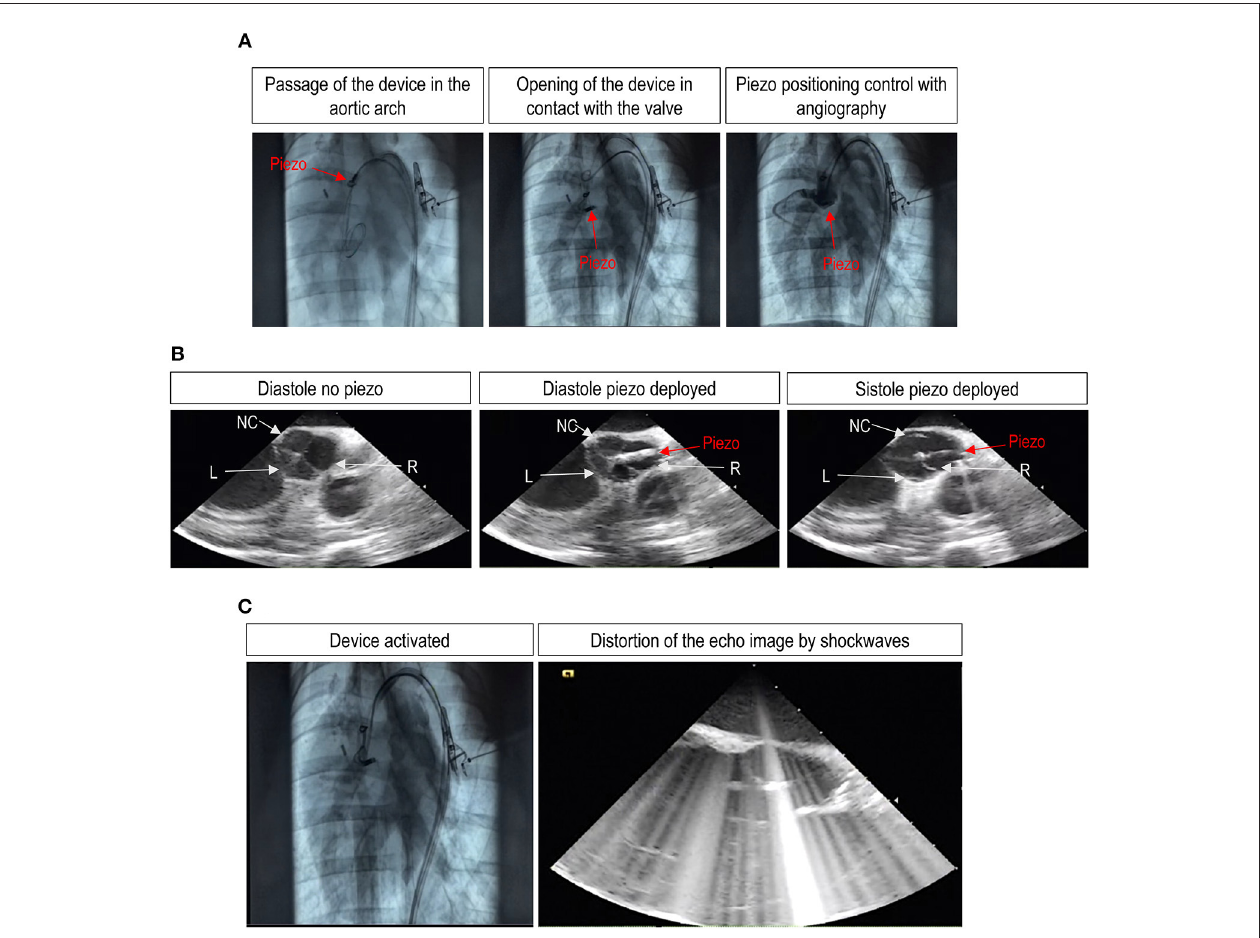
FIGURE 4 | Angiographic and echocardiographic assessment of successful TDD deployment and leaflet treatment with a trans-femoral access in vivo . (A) Shows the deployment of the device through the femoral artery from an initial position at the level of the ascending aorta and down to the positioning of the piezo in the Valsalva sinus of the right aortic valve leaflet. (B) Shows three images of an echocardiographic sequence showing the motion of the valve leaflets in the presence of the piezo deployed at the level of the right leaflet. The pictures of the sequence show, respectively, the correct closure of the three leaflets before piezo deployment (left picture), the closure of the valve after piezo deployment (center picture), and the opening of the left (L) and the non-coronary (NC) leaflets or the blockade of the right (R) leaflet by the deployed piezo at systole (right picture). The complete sequence is provided as Supplementary Video 1 . (C) Shows, finally, static images of the angiography and the echocardiographic sequences during activation of the piezo. It is evident on the right the interference of shockwaves with the ultrasounds, making it impossible to distinguish the structure of the